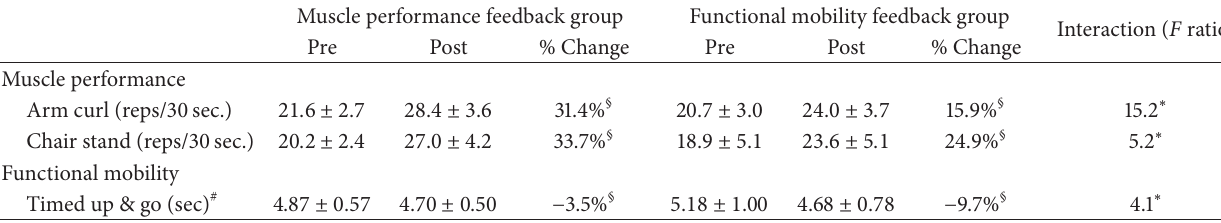
Table 2: Improvements in muscle performance and functional